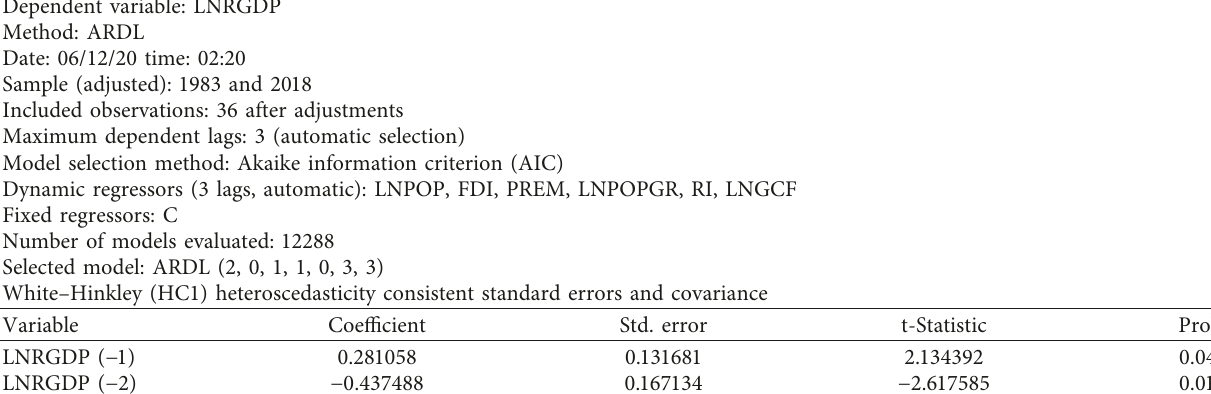
Table 3: ARDL model selection